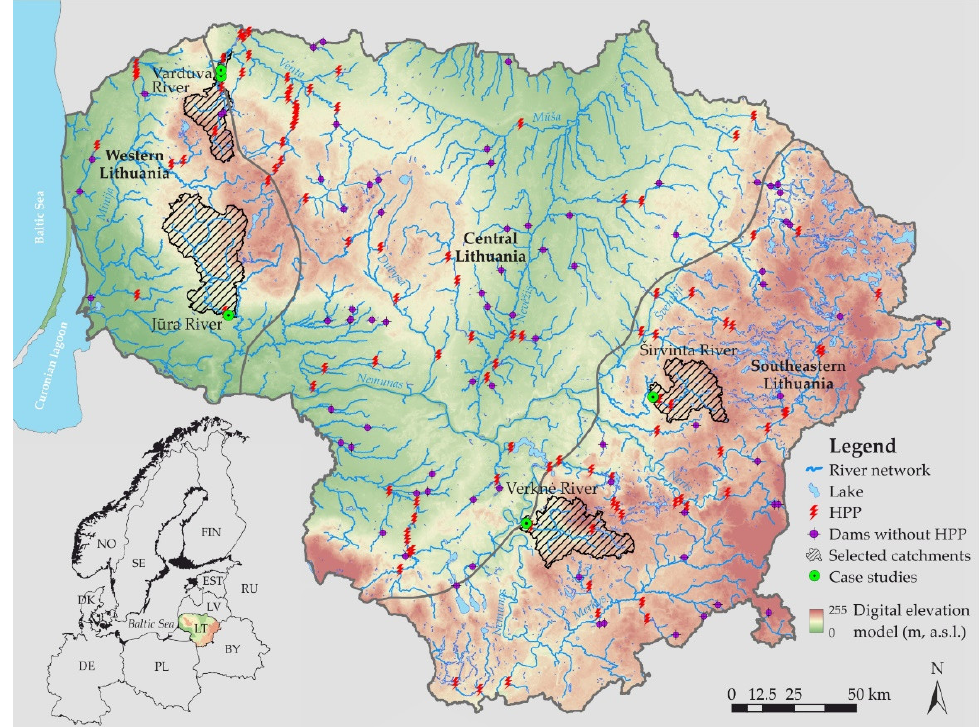
Figure 1. Study area and selected case study river catchments in the context of Lithuanian hydropower plants (HPPs) and dams without HPP, the inundated area of reservoirs of which is 50 ha and more.